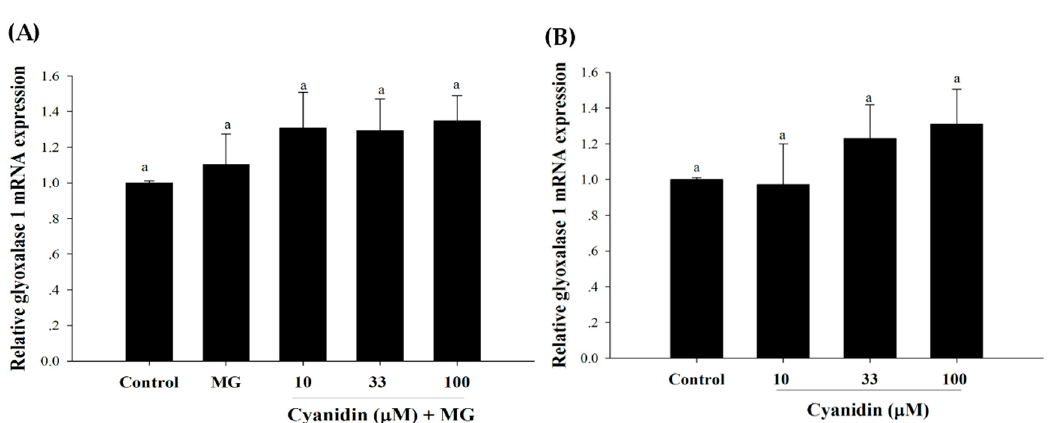
Figure 7. Effect of cotreatment of cyanidin and 500 µM methylglyoxal (MG) for 12 h on the mRNA expression of glyoxalase 1 (Glo-1). ( A ) The mRNA expression of Glo-1 was not reduced by MG or its treatment with cyanidin. ( B ) Cyanidin (10–100 µM) alone had no effect on the mRNA expression of Glo-1. Results are presented as mean ± SEM ( n = 3). The groups that do not share a common letter are significantly different ( p < 0.05).